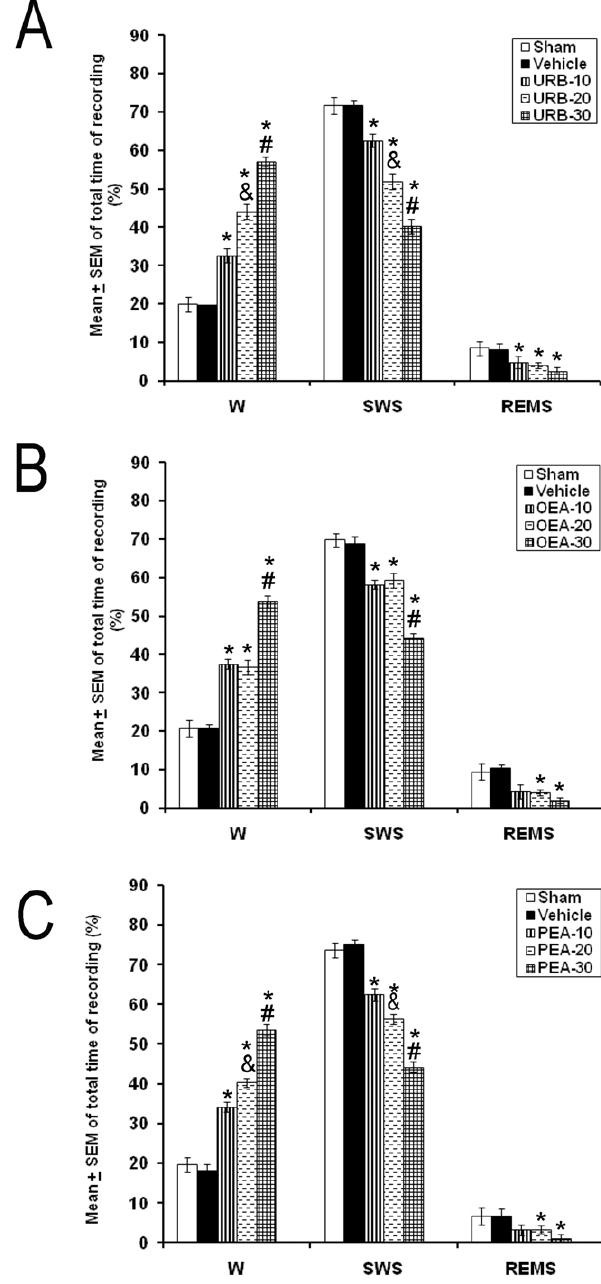
Figure 2. Effects on total time (3 h of sleep recordings) of wakefulness (W), slow wave sleep (SWS) and rapid eye movement sleep (REMS) after administrations into the lateral hypothalamus of either URB597 (Panel A), OEA (Panel B) or PEA (Panel C). Pharmacological treatments (10, 20, 30 m g/1 m L; each compound) increased W and diminished SWS as well as REMS (Mean 6 SEM of total time of recording [%]; * vs. Sham/Vehicle, p , 0.05; # vs. respective compound at 10 or 20 m g/1 m L, p , 0.05).